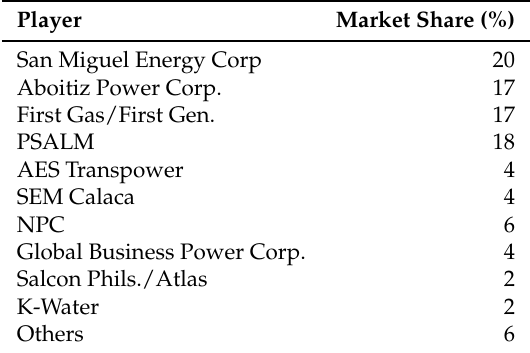
Table 1. Key generation players’ share in the Philippines